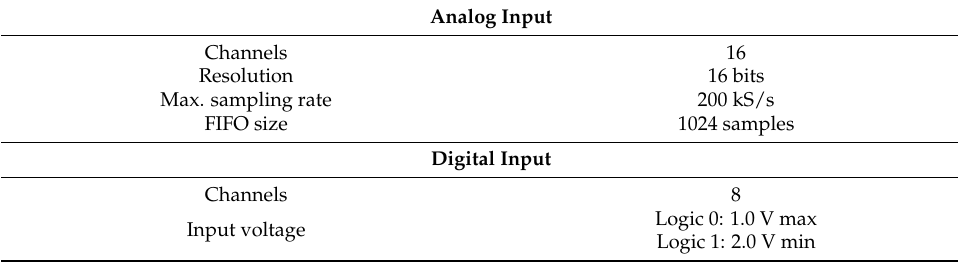
Table 3. Data acquisition module specifications.